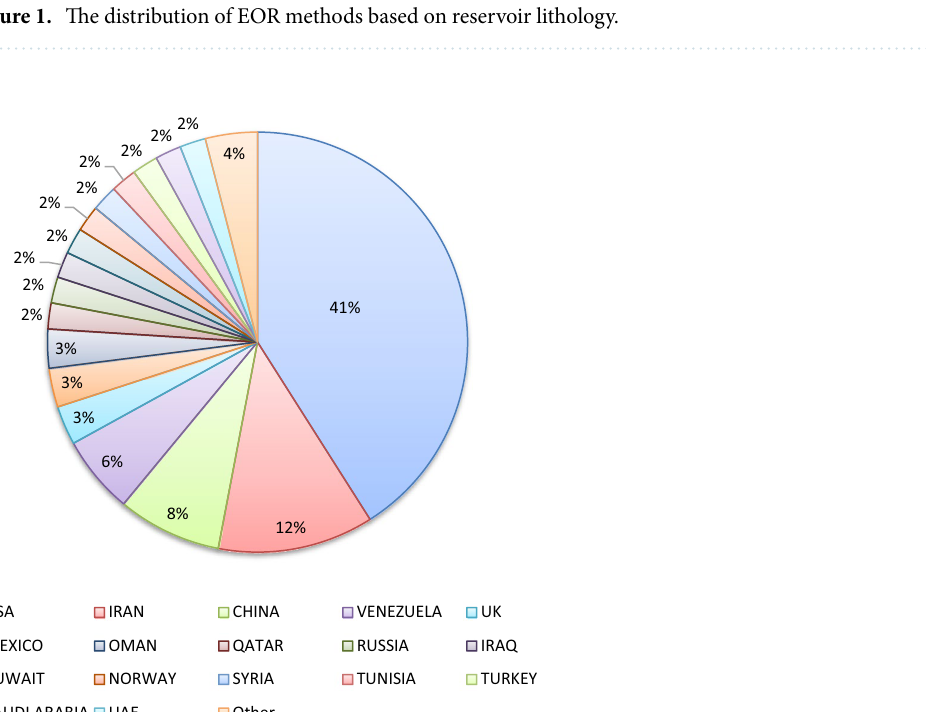
Figure 1. The distribution of EOR methods based on reservoir lithology.